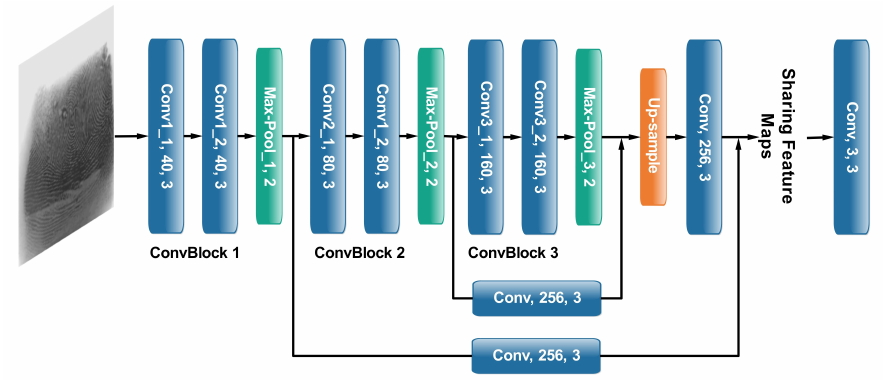
Figure 3. The proposed FCN